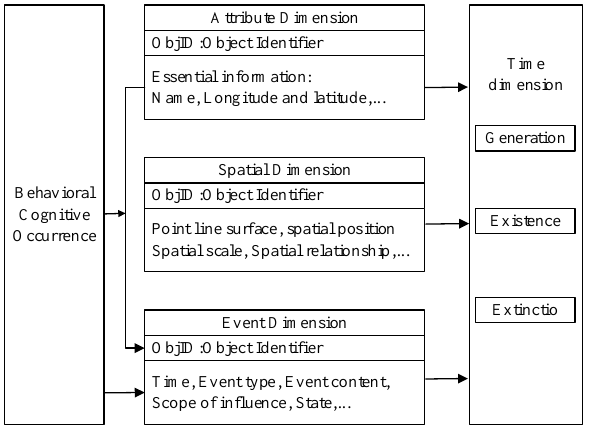
Figure 4. Behavior-event model